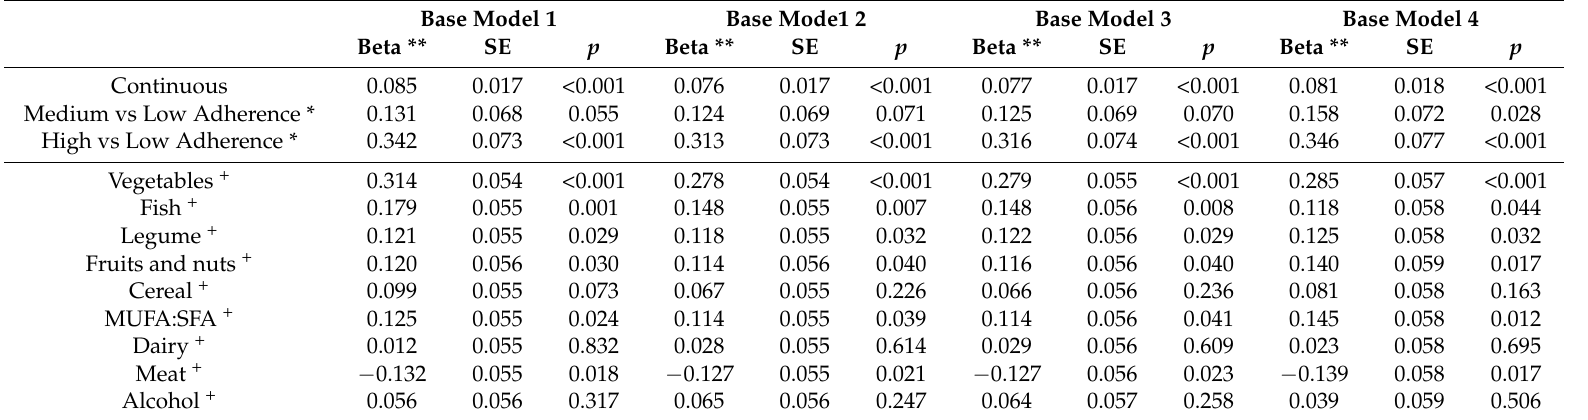
Table 3. Association of Mediterranean Diet Score with MMSE longitudinal